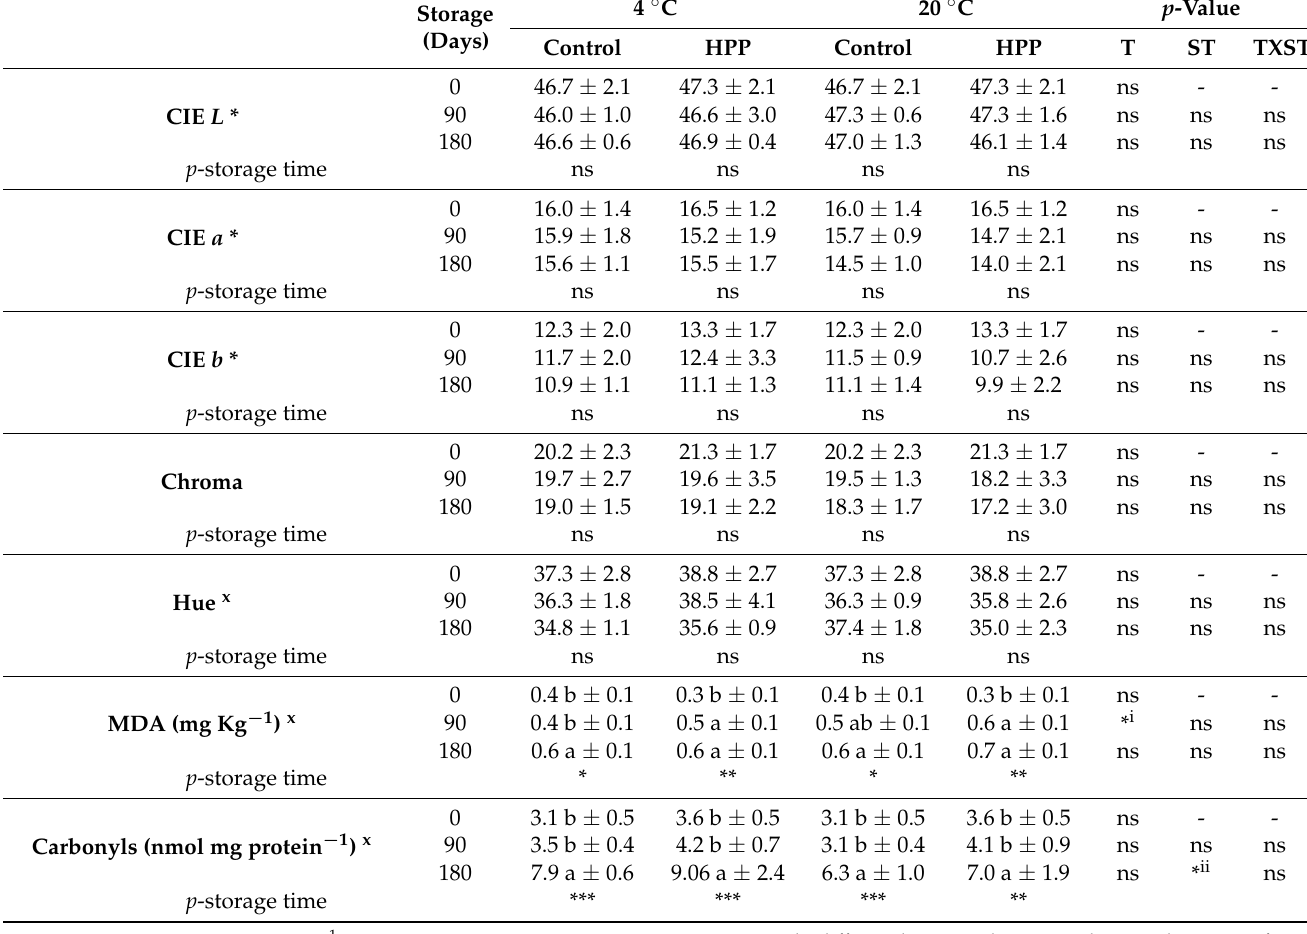
Table 3. Instrumental color and oxidative parameters (mean ± standard deviation) of sliced Iberian chorizo HPP-treated (HPP) or not (Control), not stored (0) or stored at 4 or 20 ◦ C for 90 or 180 days, and significance from a one-way (storage time) ANOVA, a one-way (T, HPP) ANOVA on day 0 data, and a two-way (T, HPP; ST, storage temperature) ANOVA with interaction. For variables with significant interaction in Table 5, a Simple Main Effects test was performed. 1